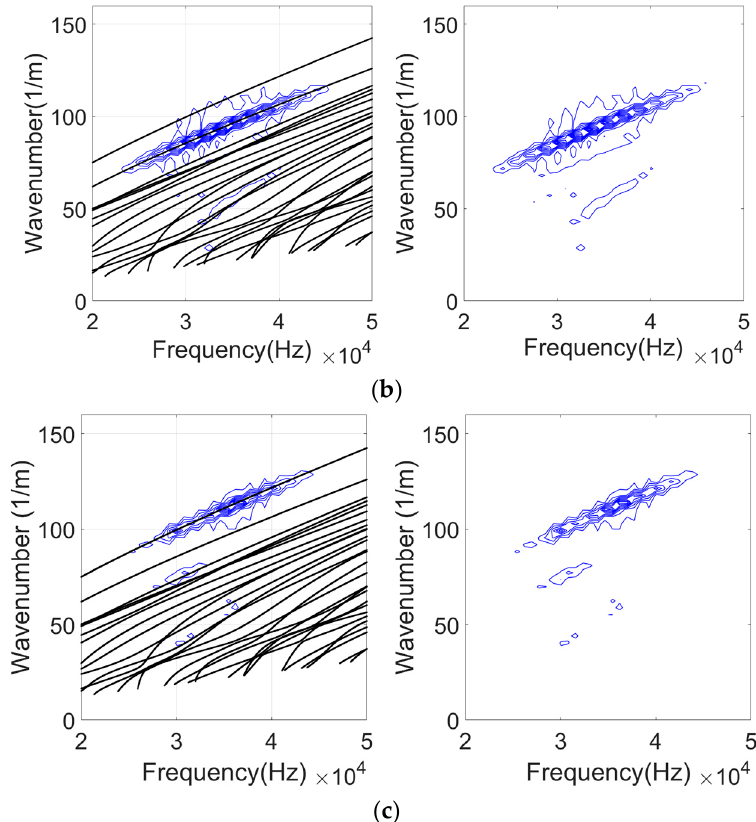
Figure 9. Frequency wavenumber curves. ( a ) 2D-FFT result of mode 7; ( b ) 2D-FFT result of mode 3; ( c ) 2D-FFT result of mode 1.